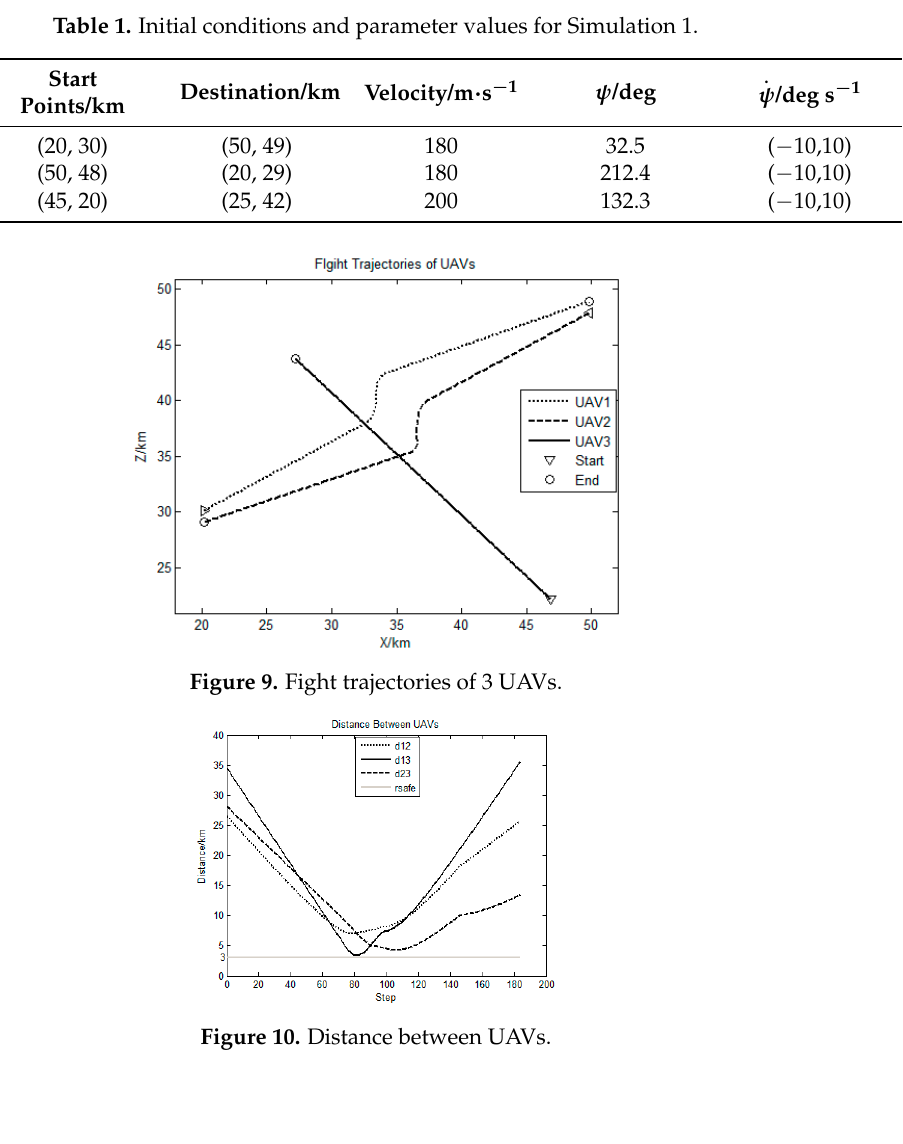
Table 1. Initial conditions and parameter values for Simulation 1.